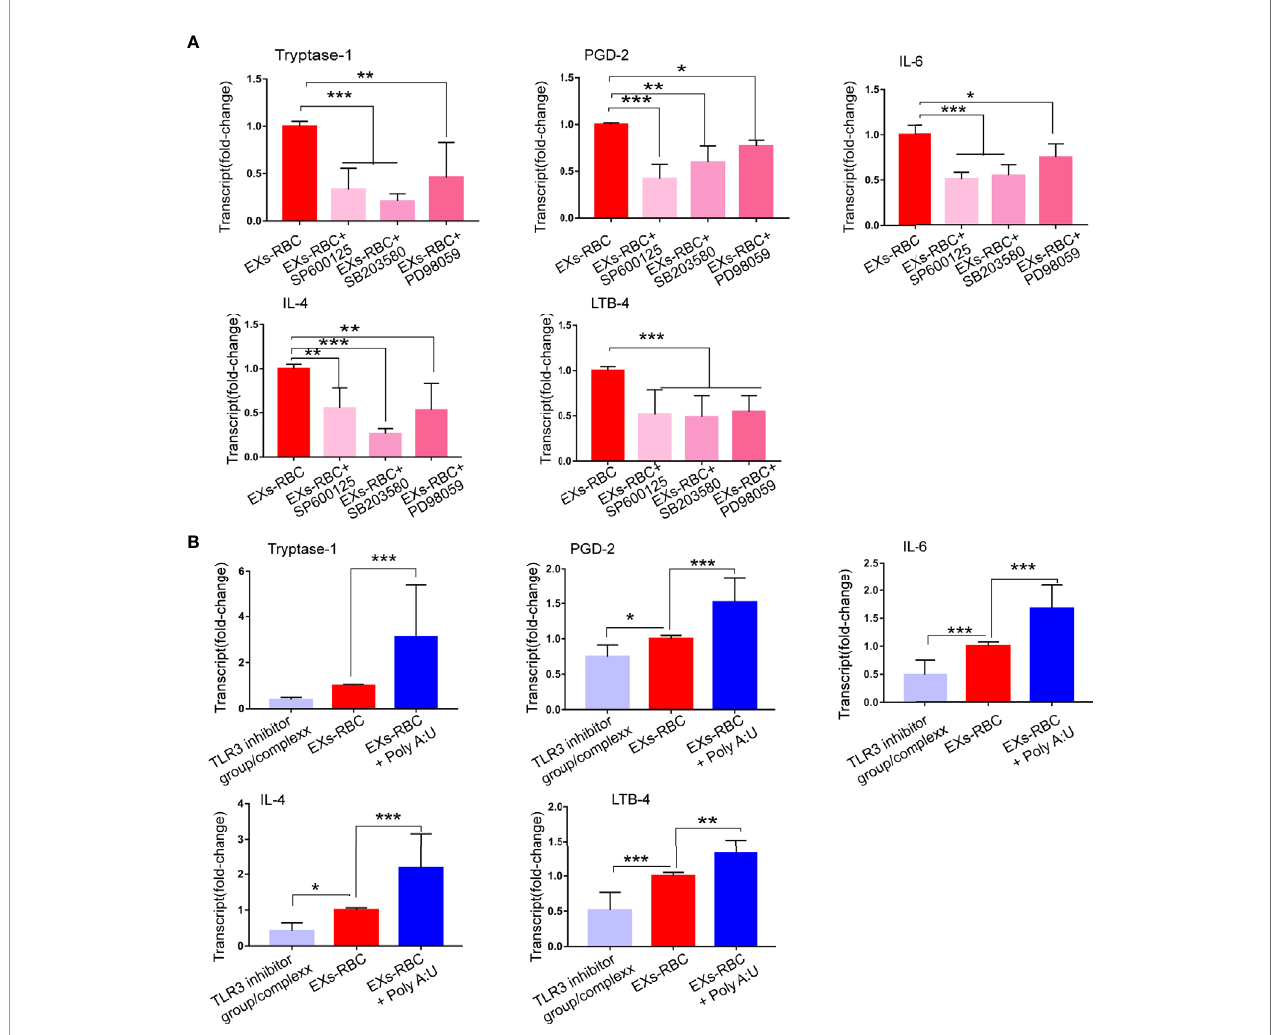
FIGURE 6 | Regulation of the production of in fl ammatory mediators by MAPK inhibitors and TLR3 inhibitor and agonist. HMC-1 cells were treated with PBS, EXs- nor, EXs-RBC, EXs-RBC plus MAPK inhibitors, EXs-RBC plus TLR3 agonist and inhibit for 2 h. Cells were collected for qPCR analysis. Data of PBS and EXs-nor are not shown. Data were from 2 – 3 independent experiments. The difference within groups was normalized by values from the EXs-RBC group. ANOVA and Dunnett ’ s multiple comparisons were used to analyze the differences among groups. * represents a statistical difference (*P < 0.05; **P < 0.01; ***P < 0.001). (A) The selective P38 MAPK inhibitor (SB203580), ERK1/2 MAPK inhibitor (PD98059), and JNK pathway inhibitor (SP600125) reduced the expression of mediators in HMC-1 cells induced by EXs-RBCs. (B) The TLR-3/dsRNA complex decreased, whereas poly (A:U) increased the expression of mediators in HMC-1 cells responding to EXs- RBCs. Here, show the expression of tryptase-1, PGD-2, IL-6, IL-4, and LTB-4. Other mediators are shown in Supplemental Content 5 . EXs-nor: exosomes from normal volunteer plasma; EXs-RBC: exosomes from red cell